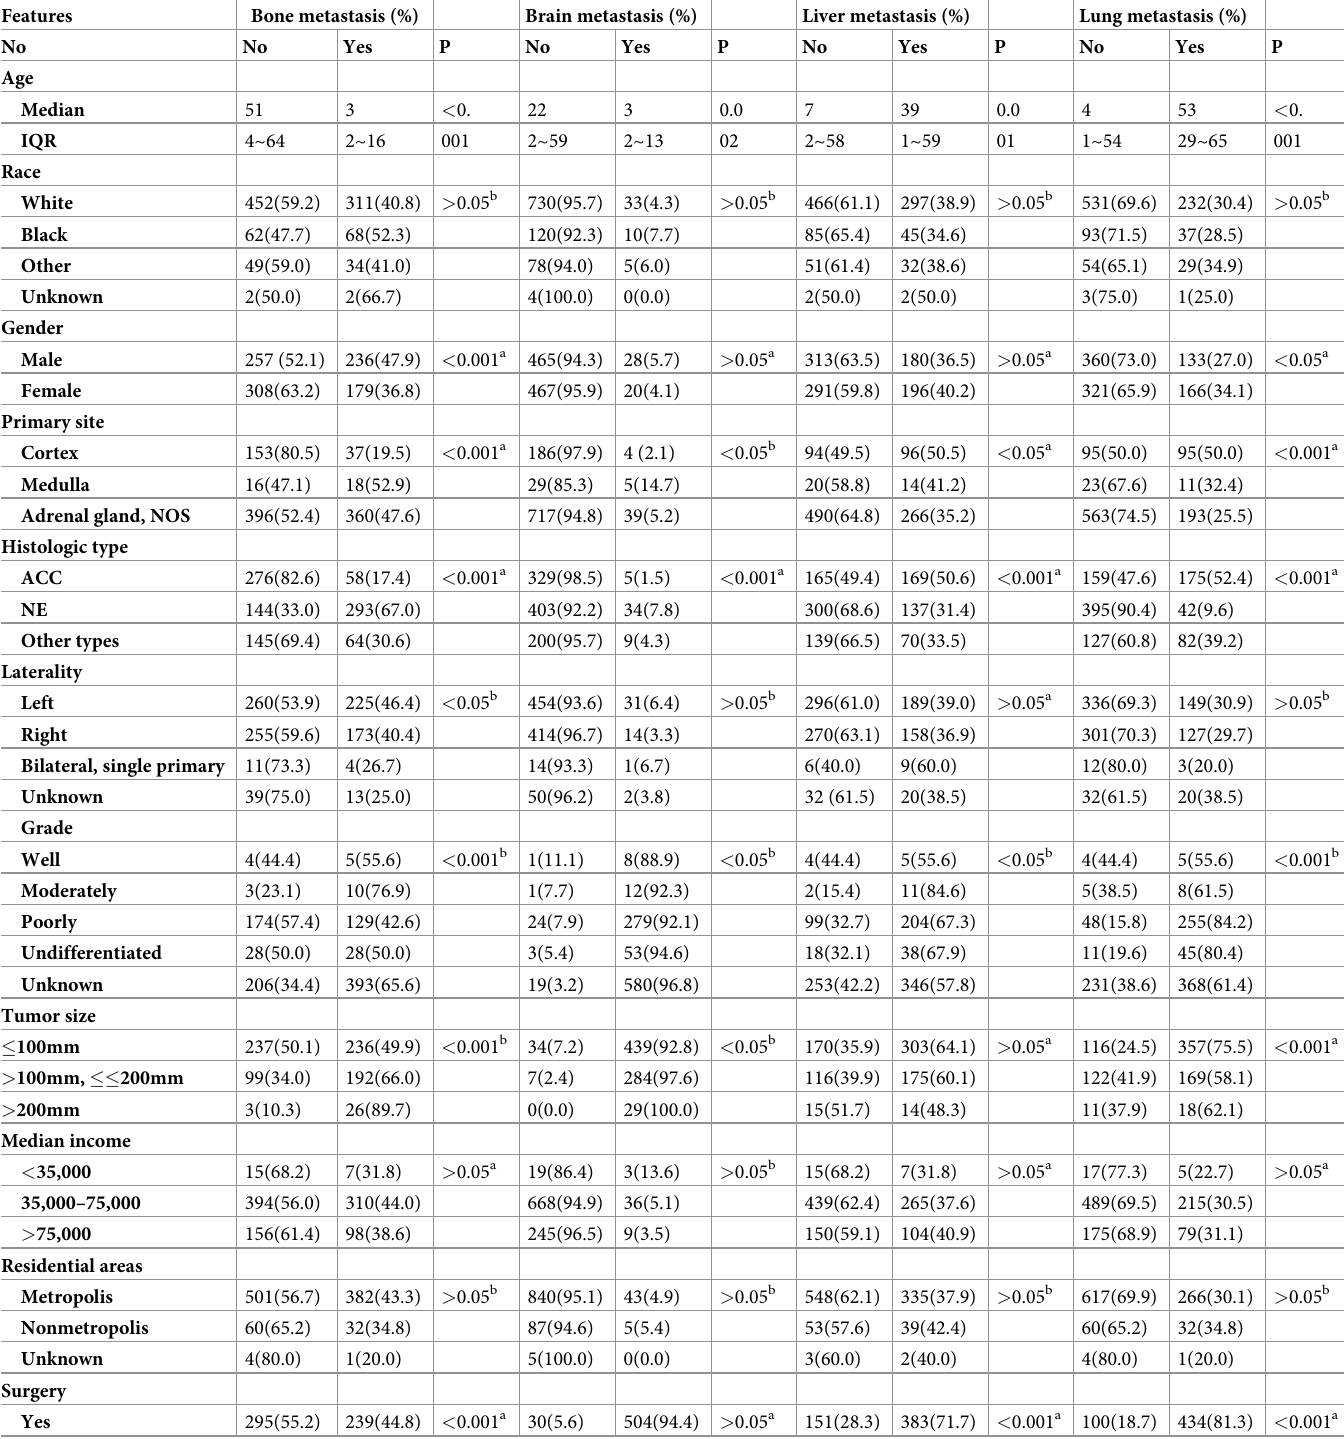
Table 2. Clinical characteristics and metastasis